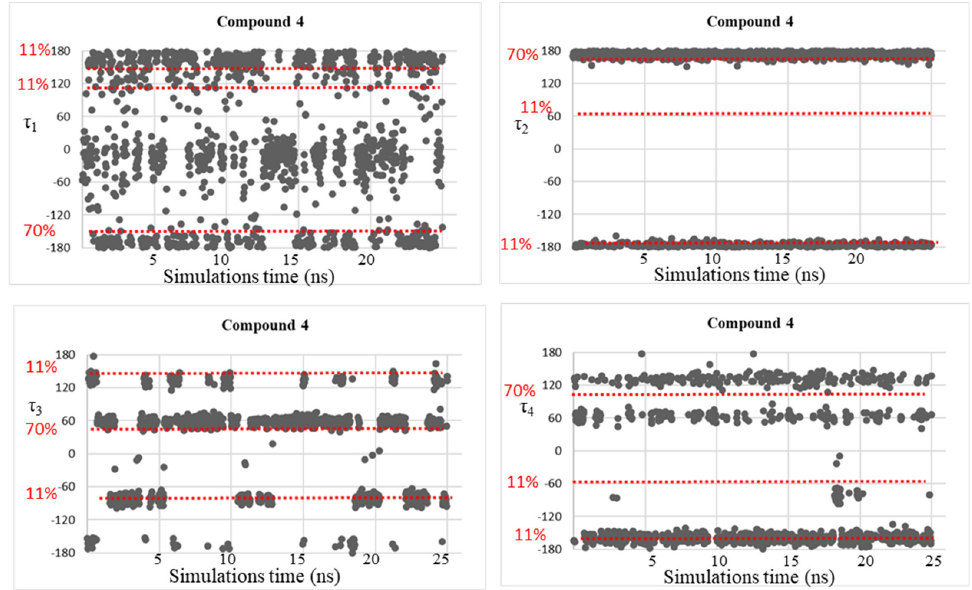
Figure 7. Dihedral torsion angle values τ 1 , τ 2 , τ 3 , and τ 4 of compound 3 over the MD simulations. The red dotted line highlights the torsional angles values found by DFT calculations in the most populated energy minima. The red label on the left displays the corresponding population percentage.